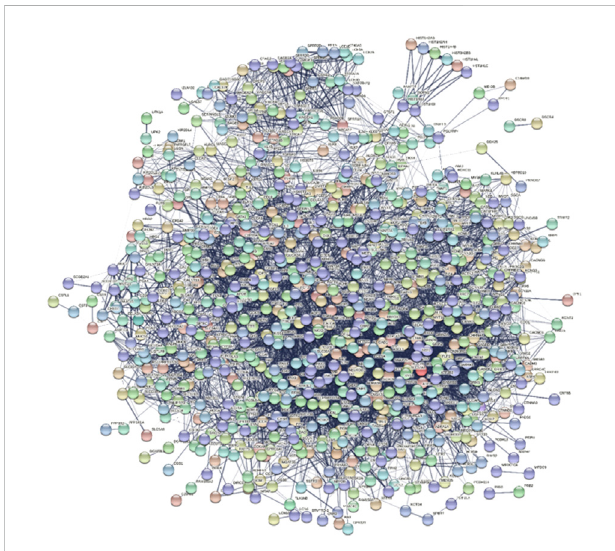
FIGURE 6 Protein-Protein Interaction (PPI) Network of intersection DEGs.